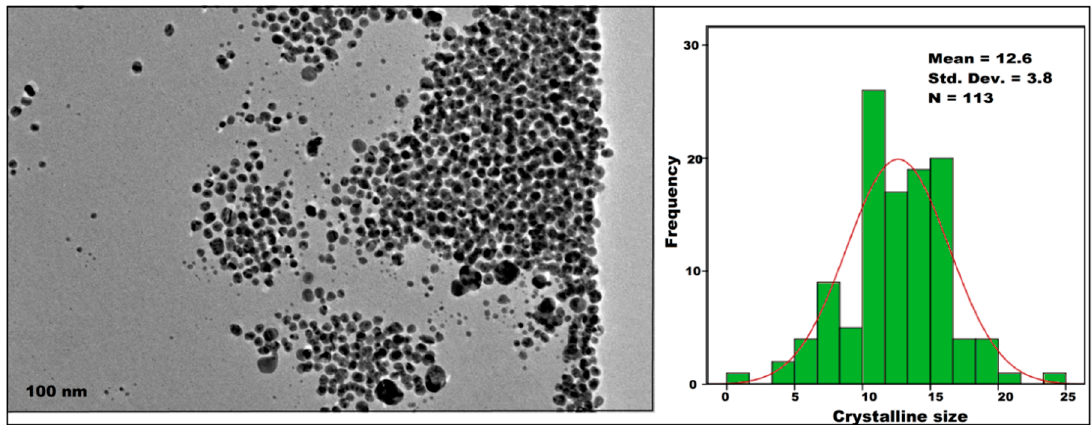
Figure 7. HRTEM analysis of C-Ag NPs from C2 (0.25 g) samples showing that NPs are spherical.